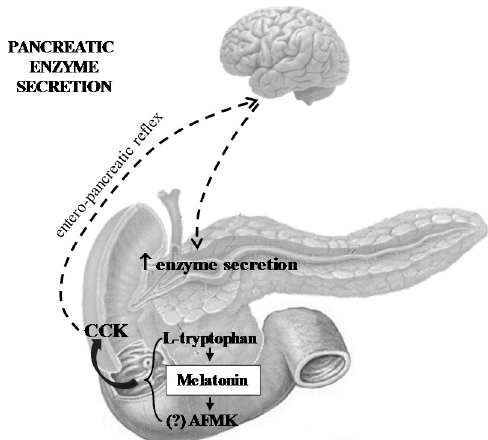
Figure 1. The effect of melatonin, its precursor L -tryptophan, and melatonin metabolite AFMK on pancreatic enzyme secretion. AFMK: N 1 -acetyl- N 1 -formyl-5-metoxykynuramine, CCK: cholecystokinin, dotted line arrow: nervous signal transmission via vago-vagal, entero-pancreatic reflex, up arrow: nervous signal delivery, bold arrow: CCK release stimulated by L-tryptophan, melatonin, and probably (?) by AFMK.